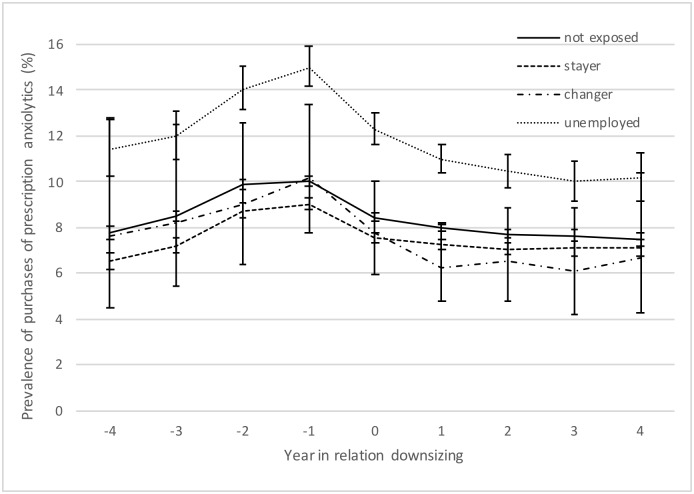
Prevalence of purchased prescribed anxiolytics among people with a previous sickness absence history.Adjusted for sociodemographic factors and with 95% CI.